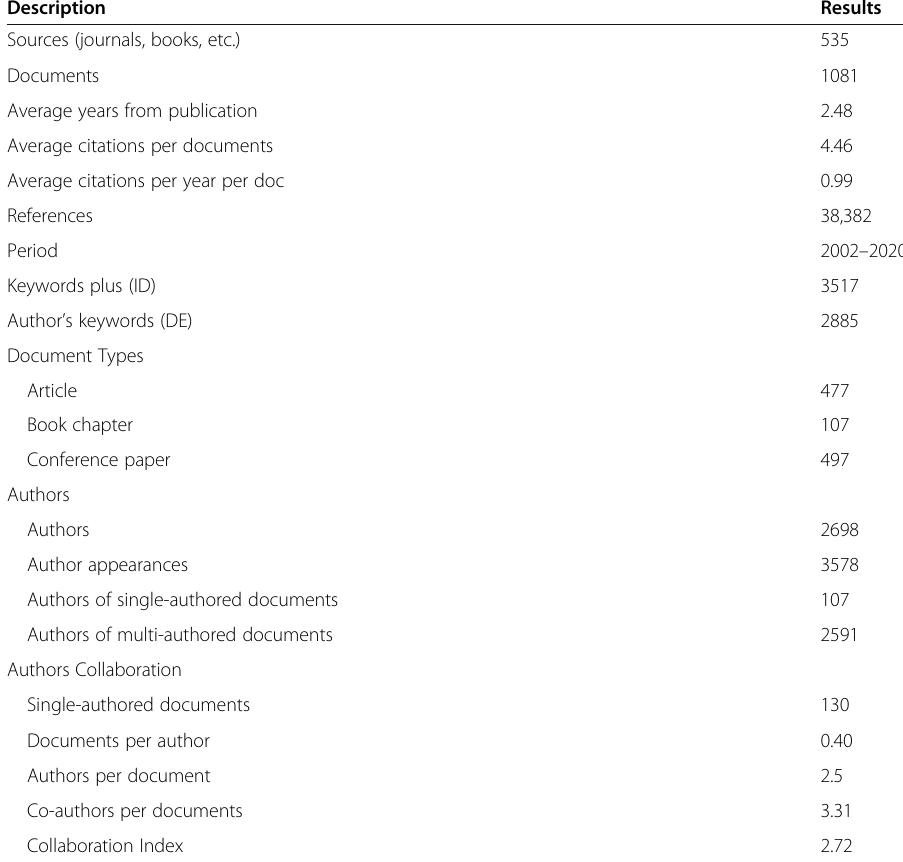
Table 2 Data synthesis indicating primary information and summary of the dataset Description Results Sources (journals, books,